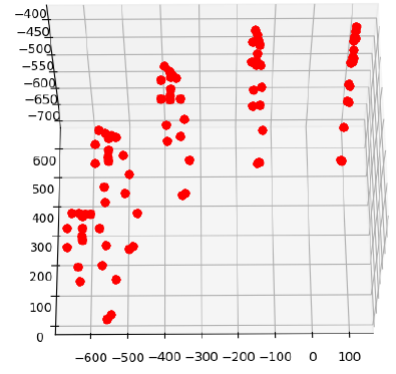
Figure 13. This figure shows examples of data inflation, represented by samples of the 18 nodes body model: ( a ) acquired body model; ( b ) body model after adding gaussian noise, to simulate errors in OpenPose; ( c ) acquired body model; ( d ) body model after performing an homothety, that is, to simulate different image depths.